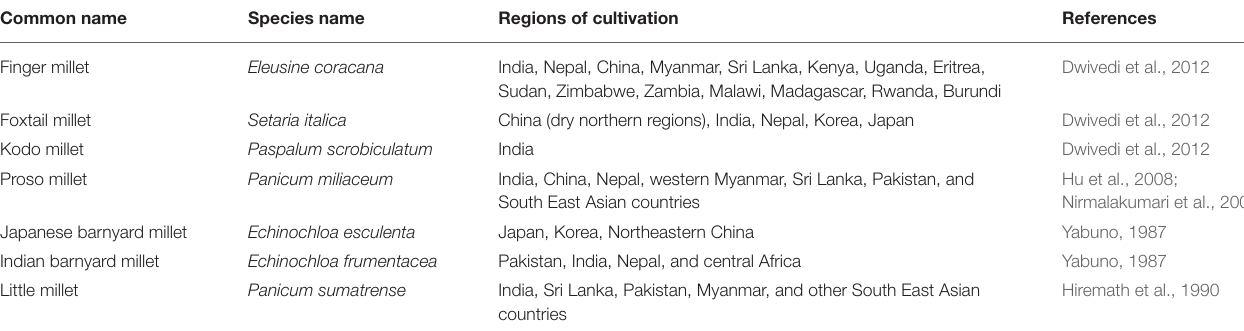
TABLE 1 | Areas where small millets are cultivated in significant quantities for human